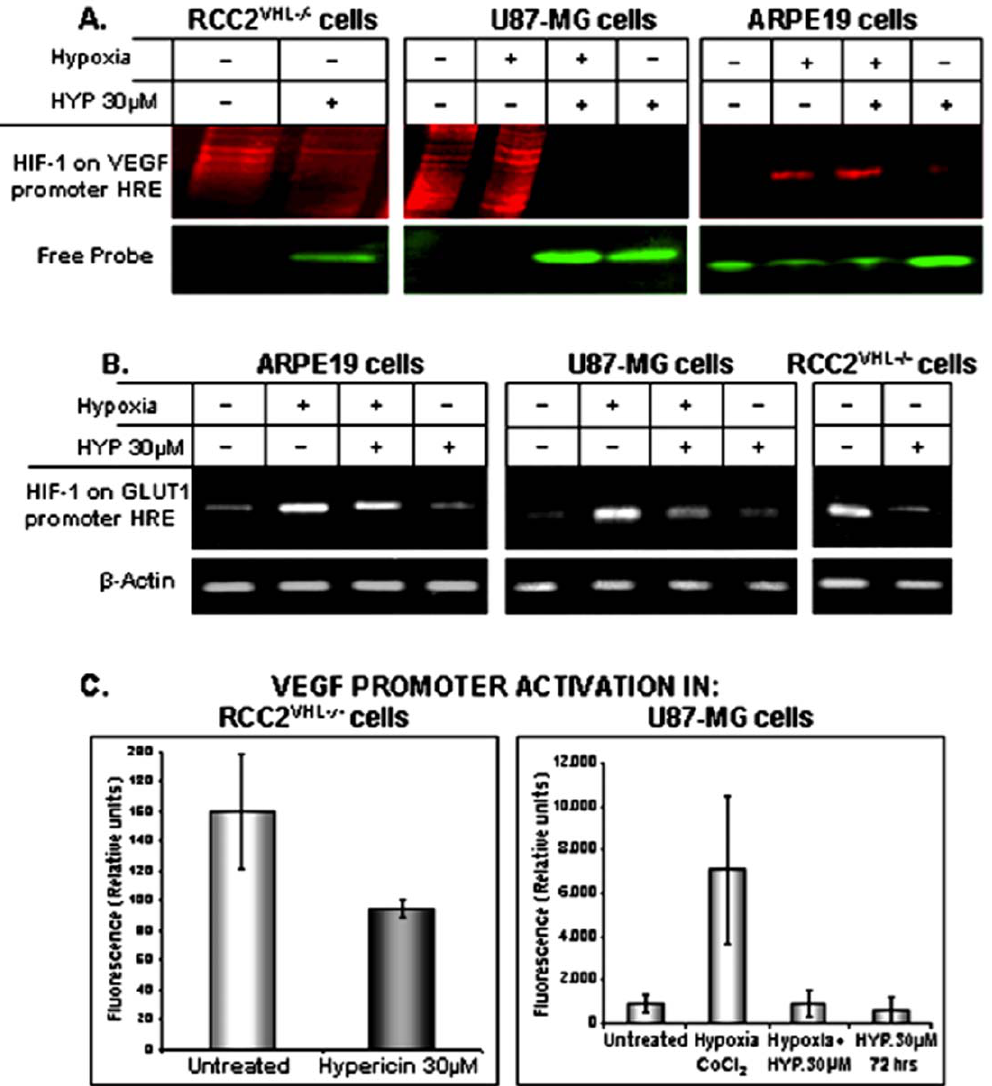
Figure 2. Interactions of HIF-1 with hypoxia response elements (HREs). Found on promoters of: [A]. The VEGF gene, analyzed by Fluorescence Electromobility Shift Assay (F-EMSA). Nuclear proteins were separated on 6% SDS-PAGE, stained with SYBER Green labeled DNA probe and unbound protein detected with SYPRO Ruby protein binding fluorochrome. Gels were scanned using FL-5000 laser-based scanner. [B]. The GLUT1 gene analyzed by chromatin immunoprecipitation (ChIP). Sheared chromatin was immunoprecipitated with anti HIF-1 a antibody and DNA isolated from this chromatin was amplified with primers specific for the GLUT1 gene promoter region. [C]. Interference by hypericin with VEGF promoter activation in tumor cell lines. Left figure - C2 VHL 2 / 2 cells. Lane 1 – untreated cells, lane 2 cells treated with 30 m M hypericin for 72 hrs. Right figure - U87-MG cells. Lane 1 – untreated cells, lane 2 – cells subjected to hypoxia (150 m M CoCl 2 for last 6 hrs), lane 3 - CoCl 2 -hypoxia for last 6 hrs and hypericin 30 m M for 72 hrs, and lane 4 - hypericin, 30 m M for 72 hrs.